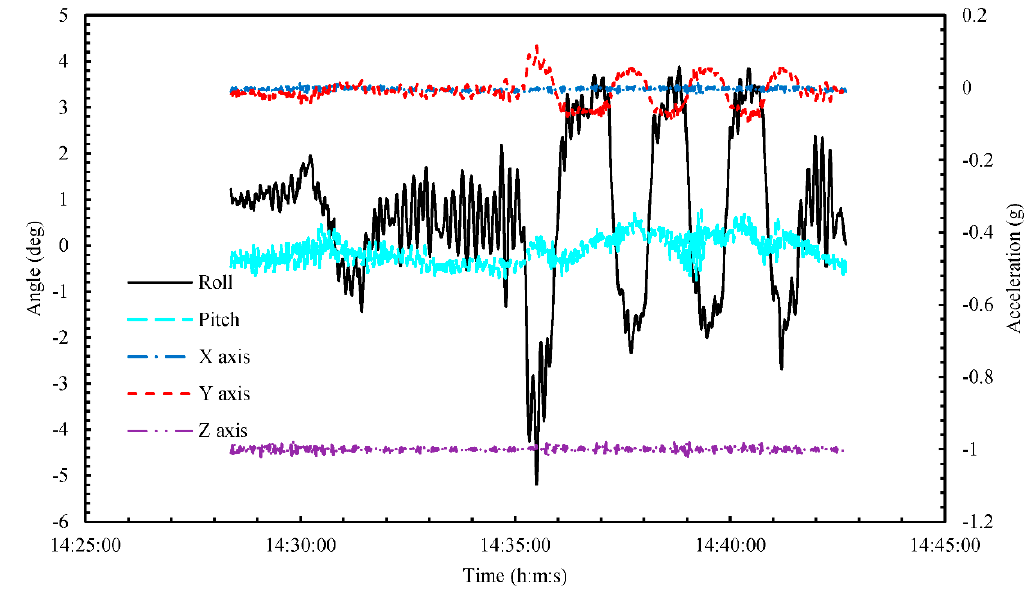
Figure 11. Time series of angle and acceleration during marine-transportation test ⑤ from 14:28 to 14:42.